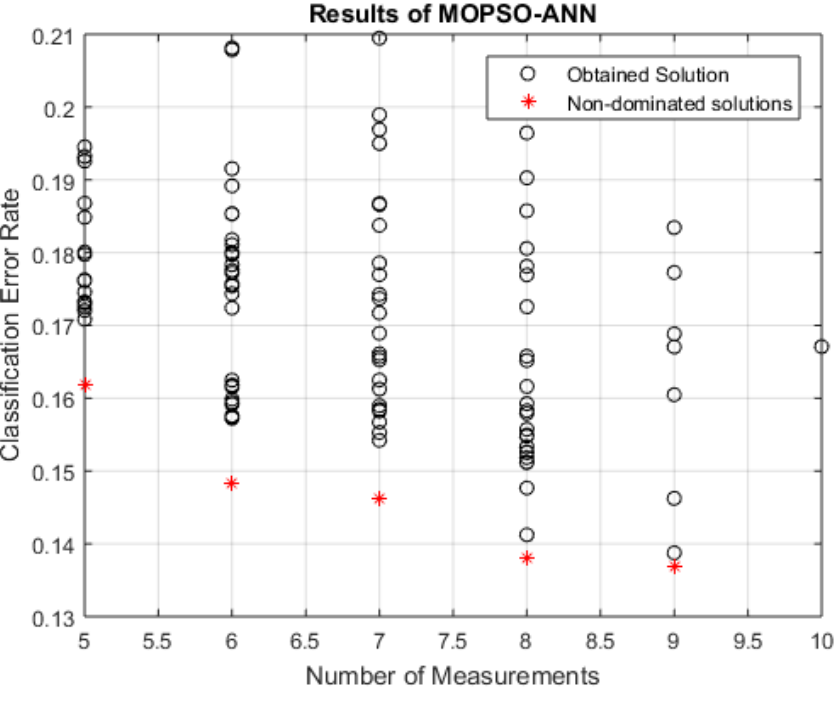
Figure 4. Non-dominated solutions obtained by MOPSO-ANN. Table 5. Results of the MOPSO-ANN.